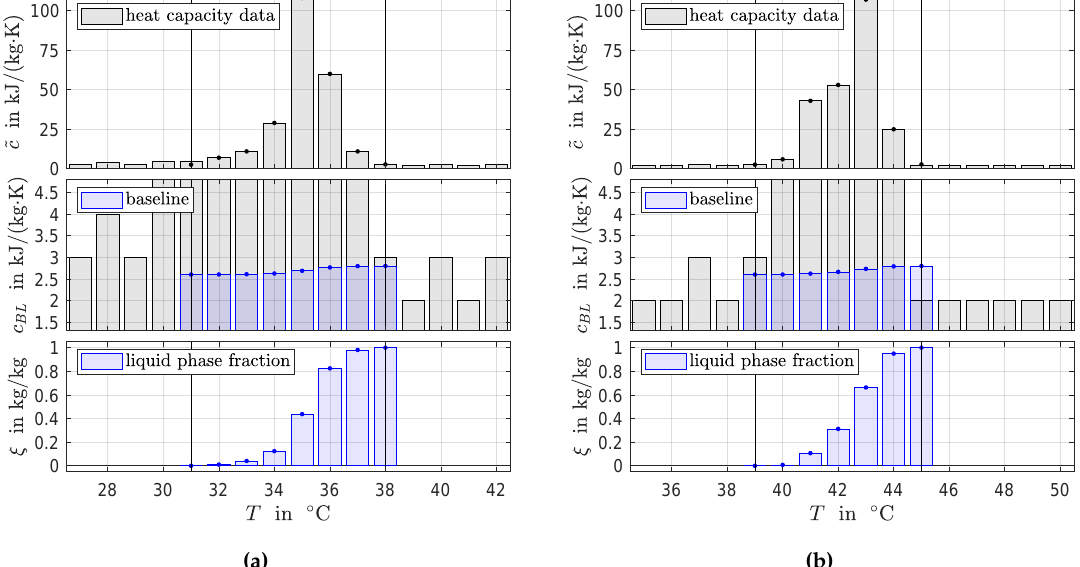
Figure 5. Area-proportional baseline method applied to heat capacity data from 3-layer-calorimetry for RT35HC ( a ) and RT44HC ( b ). The values of c s p and c l p at the start and end of the phase transition temperature range were corrected. Baseline and phase fractions are constructed as discrete signals by numerical integration.